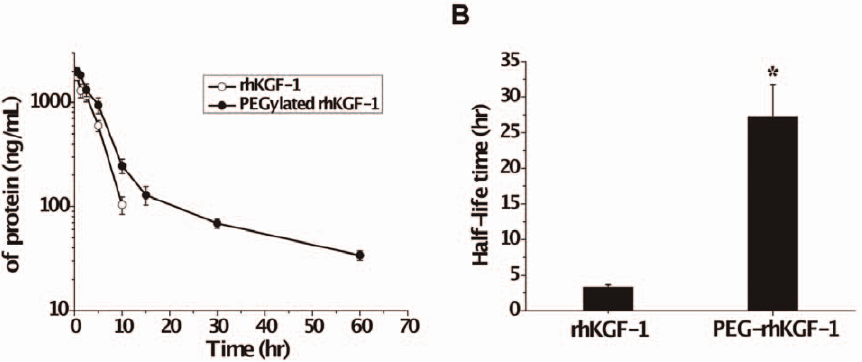
Figure 6. Pharmacokinetics study of solid-phase PEGylated rhKGF-1 in rats. Panel A. Normal male SD rats were injected intravenously with 100 m g/kg rhKGF-1 (open circle), and PEGylated rhKGF-1 (solid circle). Blood samples were collected at the indicated time points. The amount of rhKGF-1 was measured by Human KGF-basic Mini ELISA Development Kit. A standard curve was made for each rhKGF-1, n=6. Values are the mean 6 SD. Panel B. Comparison of half-life of non-PEGylated rhKGF-1 and PEGylated rhKGF-1. *, p , 0.01 vs the corresponding non-PEGylated rhKGF-1 group.